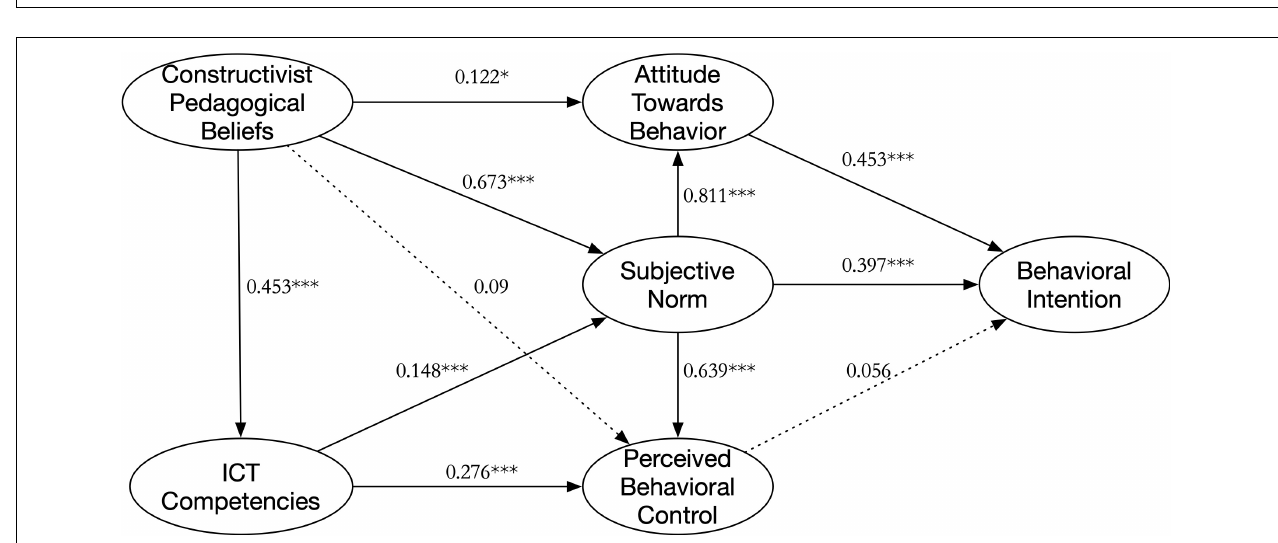
FIGURE 3 | The model of the higher grade